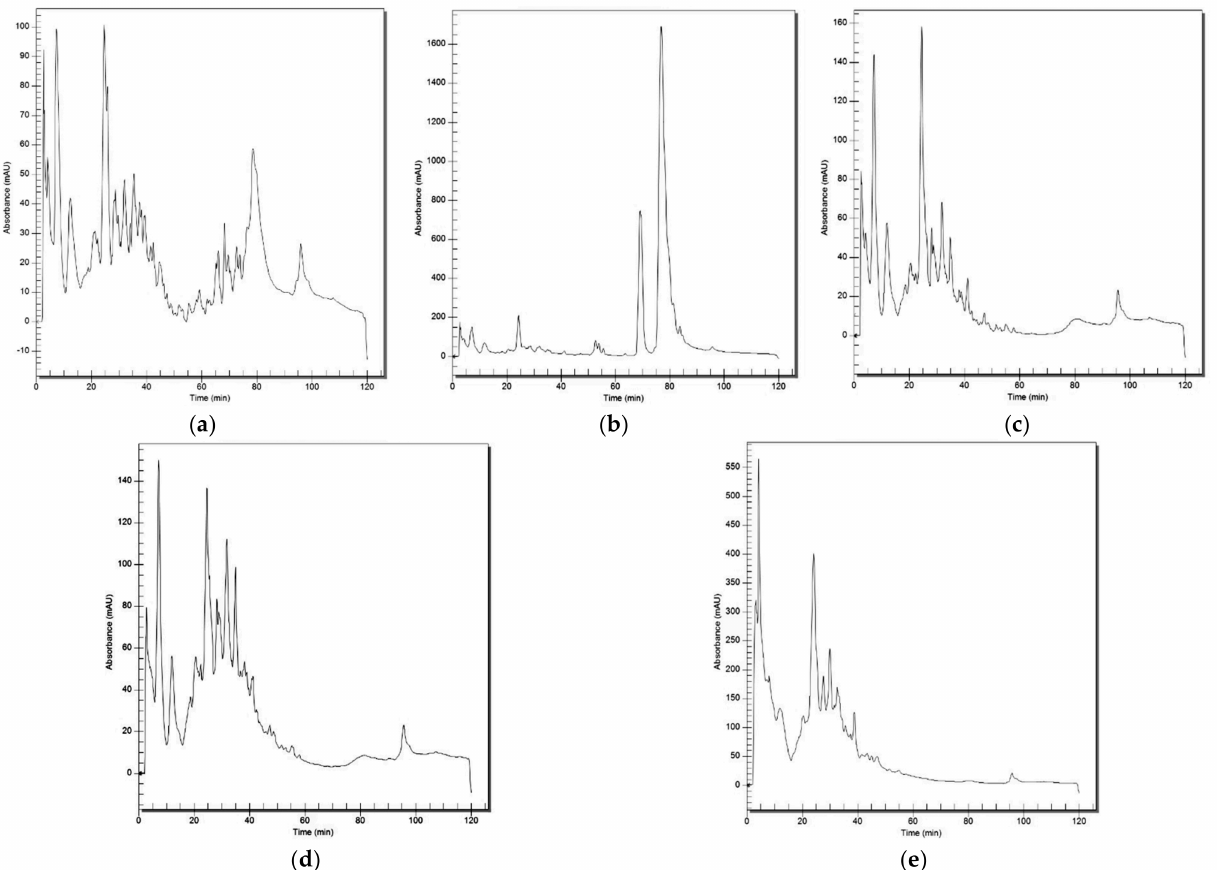
Figure 2. RP-HPLC chromatogram of the ( a ) total hydrolysed extract, ( b ) fraction containing peptides > 30 kDa, ( c ) peptides of 30 to 10 kDa, ( d ) peptides of 10 to 3 kDa, and ( e ) peptides smaller than 3 kDa. See text for experimental